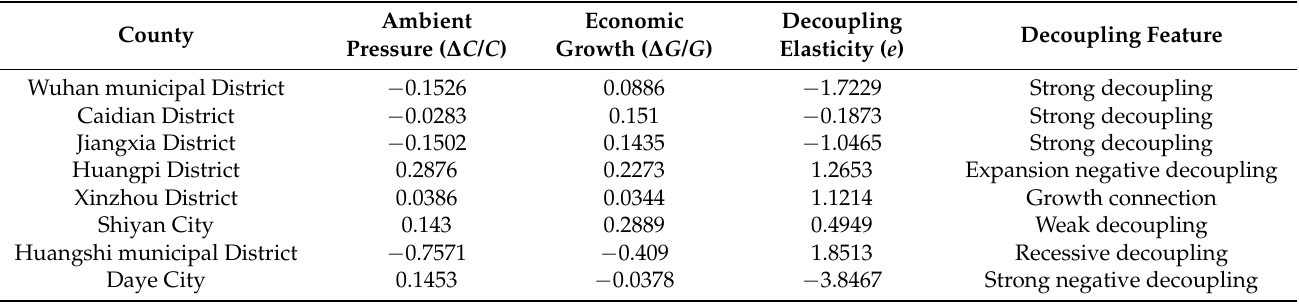
Table A2. Decoupling characteristics of carbon emissions and agricultural economic growth from 2005 to